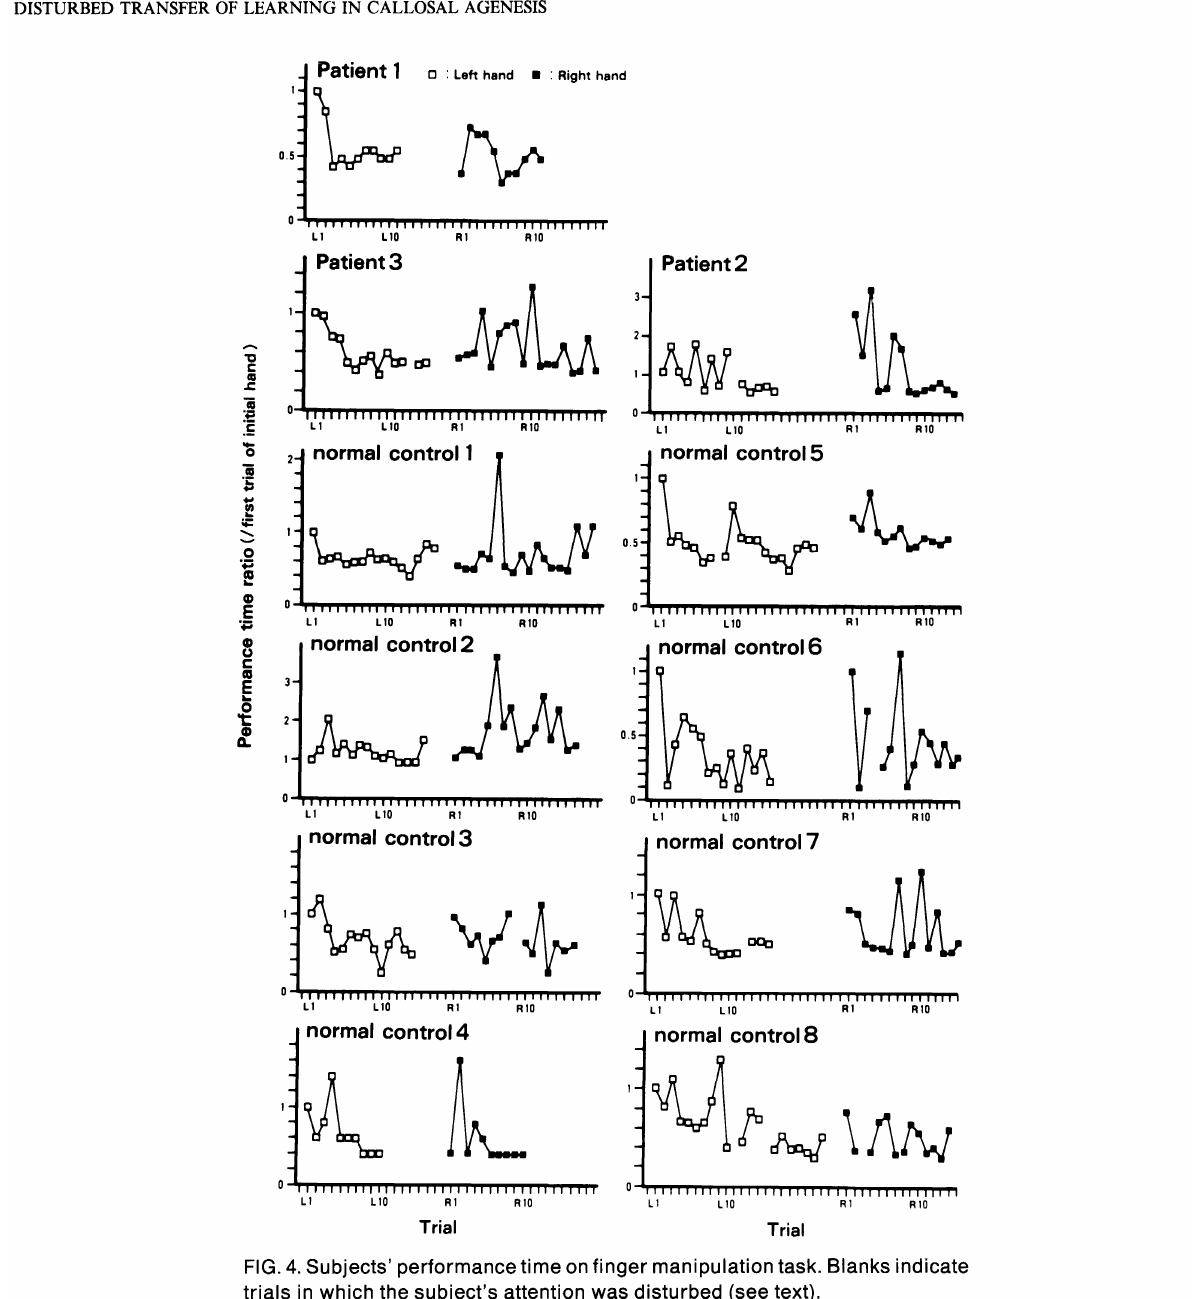
FIG. 4. Subjects' performance time on finger manipulation task. Blanks indicate trials in which the subject's attention was disturbed (see